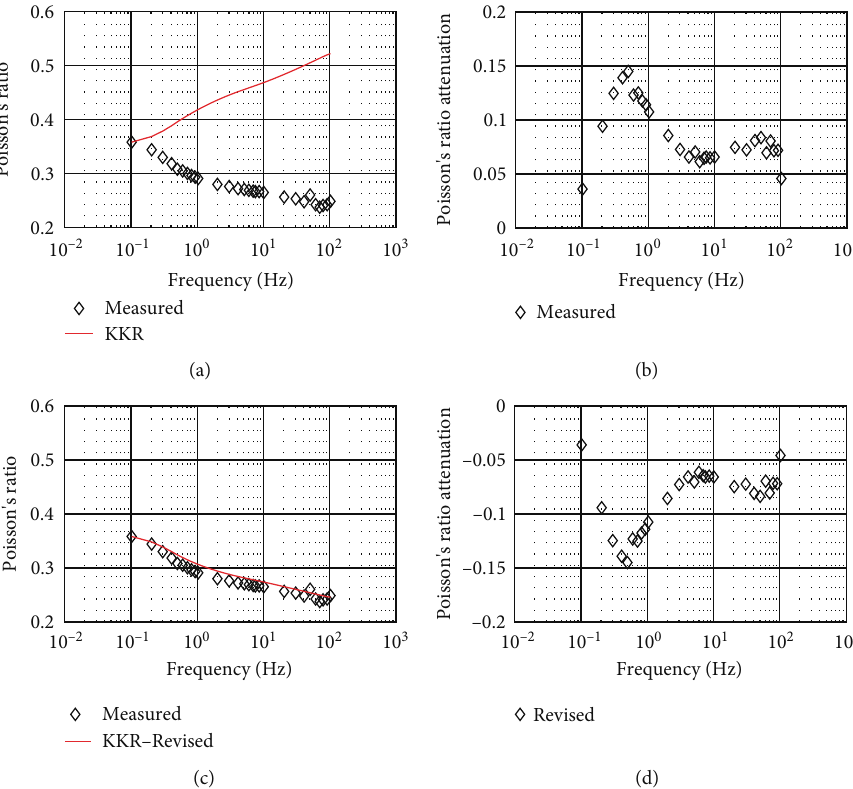
Figure 6: The frequency dependence of Poisson ’ s ratio and it associated attenuation of the glycerin-saturated Fontainebleau sandstone sample (from Pimienta et al.